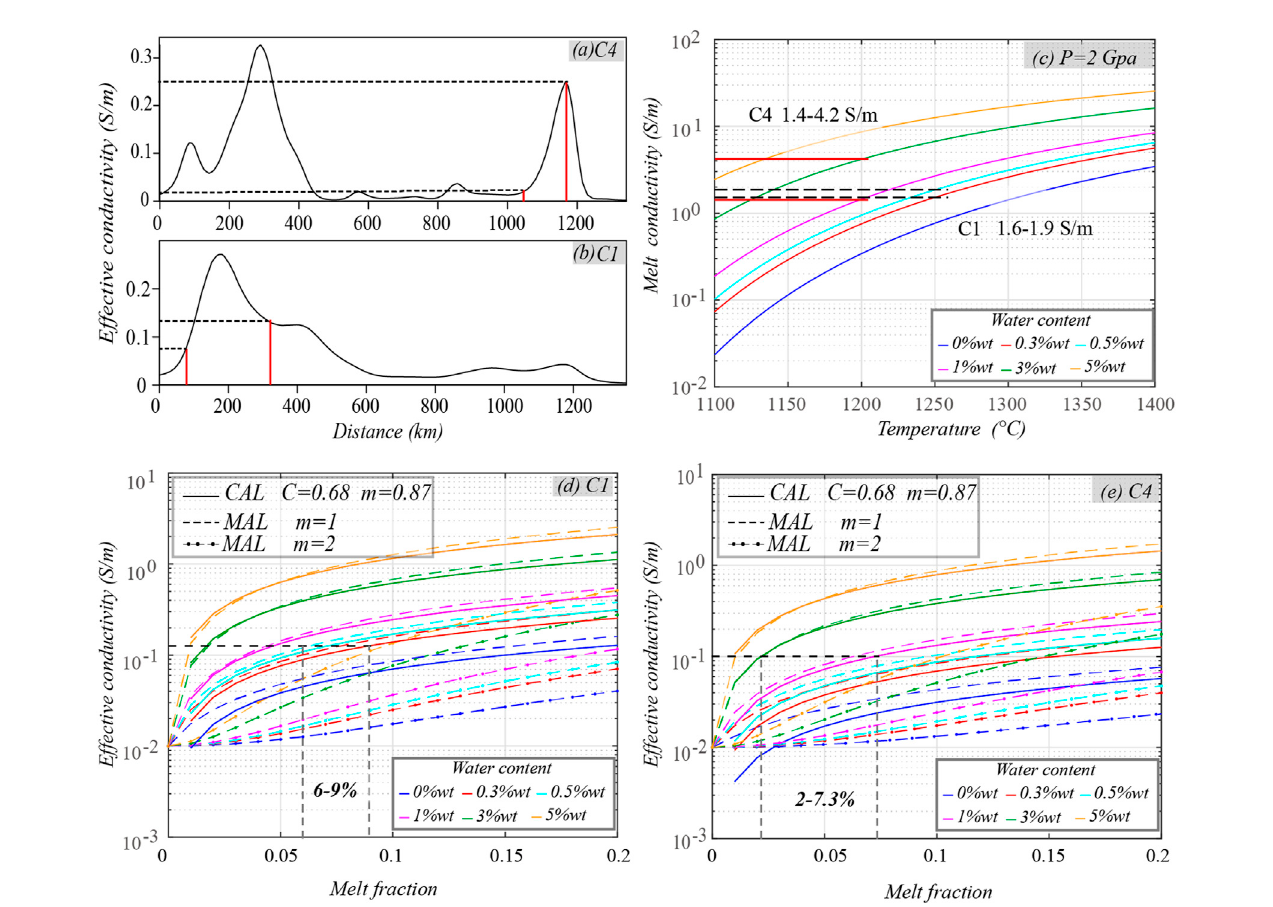
FIGURE 8 (A) and (B) TheeffectiveconductivitycurvesoftheC4andC1conductorswithinthedepthrangeof30 – 70kmand60 – 140km,respectively.Theredlines indicate the horizontal fi elds of the C4 and C1 conductors that calculated the average effective conductivities. (C) The relationship between conductivity and temperature of basalt melts with different water content according to (Ni et al., 2011). (D) and (E) The relationship between effective conductivity and melt fraction calculated using the traditional (CAL)(Archie, 1942) and modi fi ed (MAL) (Glover et al., 2000)Archie ’ s laws with different water contents. The dashed gray vertical lines in (D) and (E) represent the ranges of melt fractions of the C1 and C4 conductors,